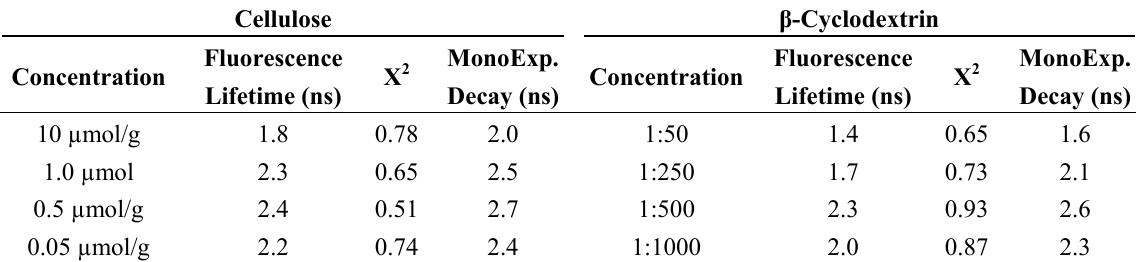
Table 1. Comparison between lifetime distribution analysis and mono-exponential analysis of the 3,3´-di(2-sulfoethyl)-indocarbocyanine dye adsorbed onto microcrystalline cellulose and on β -cyclodextrin.